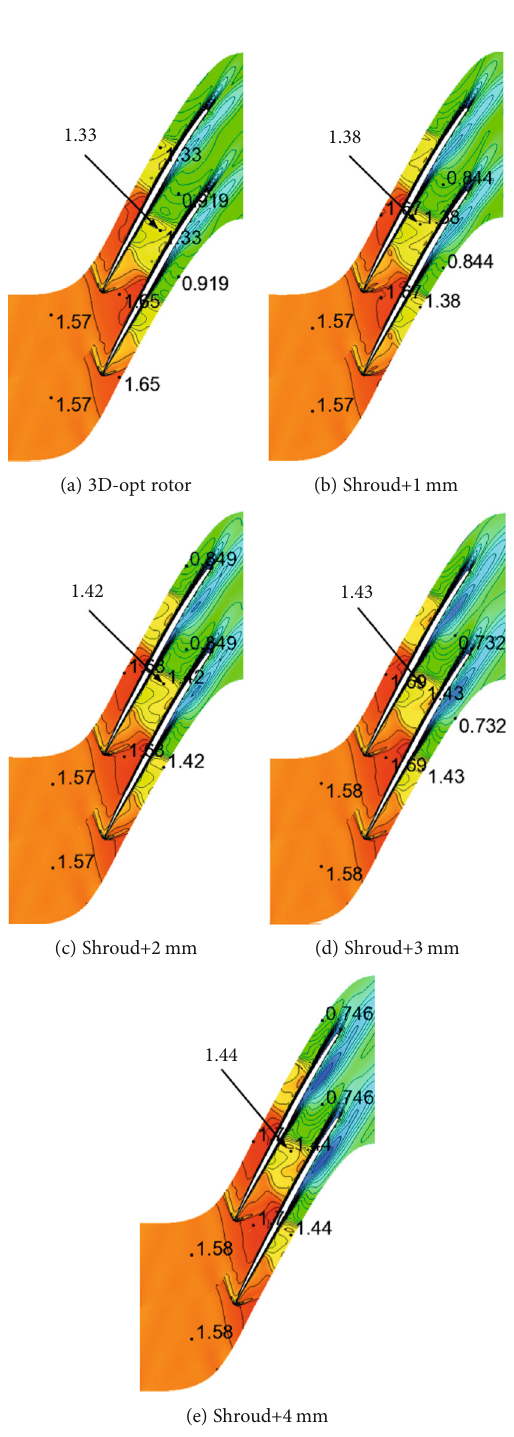
Figure 15: Mach number contours of 90% span at the design